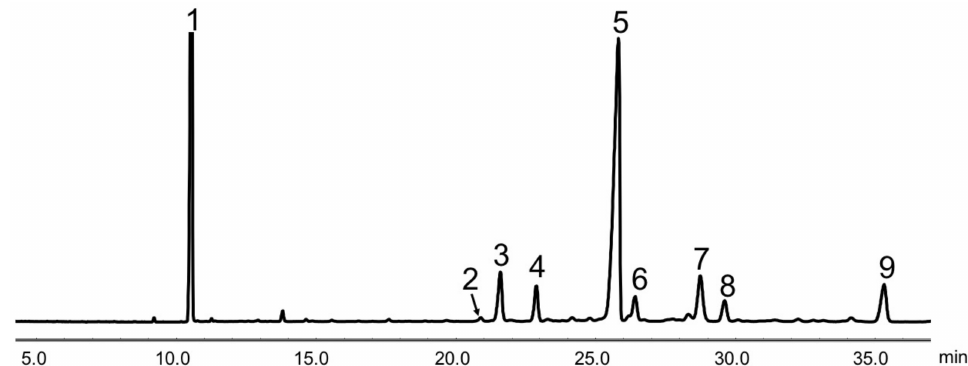
Figure 1. (internal standard); 2, ergosterol; 3, campesterol; 4, stigmasterol; 5, β -sitosterol; 6, stigmastanol;